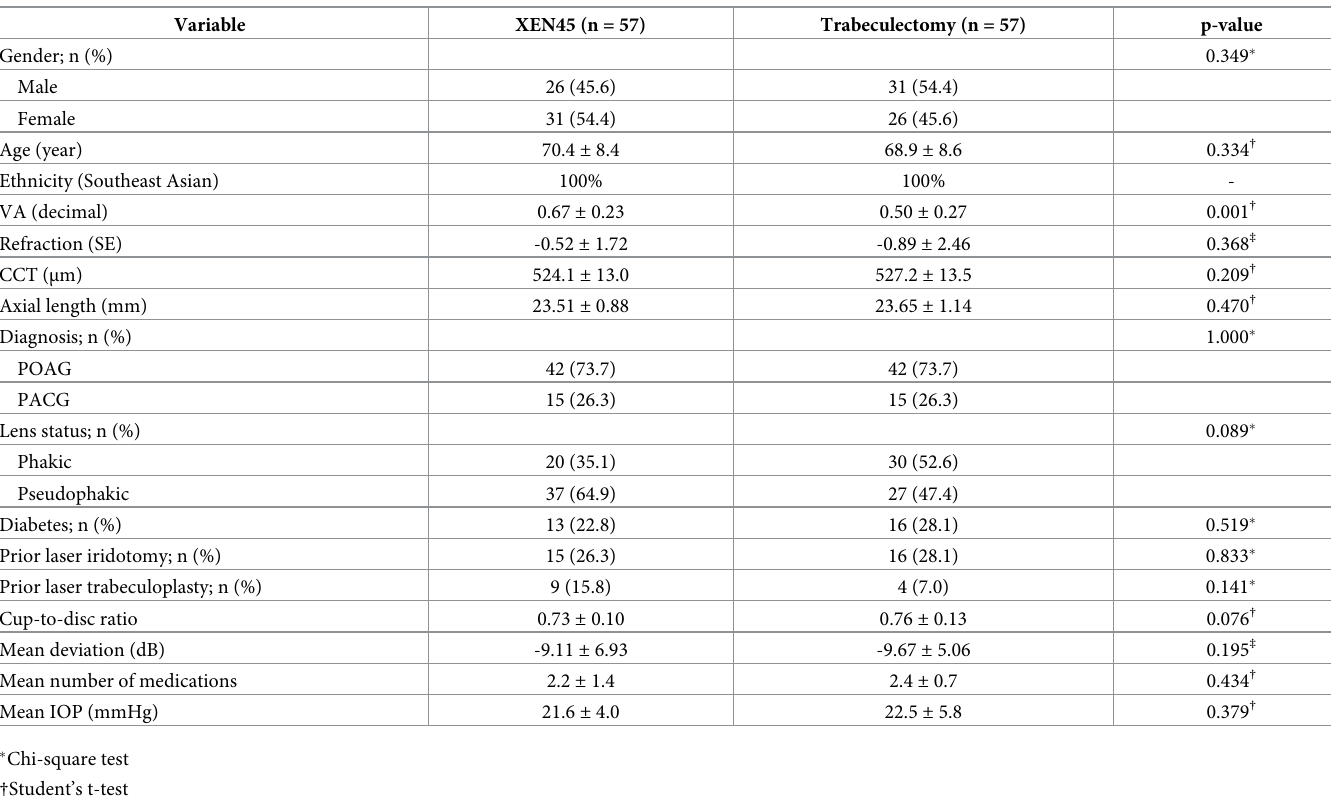
Table 1. Baseline characteristics of XEN45 and trabeculectomy